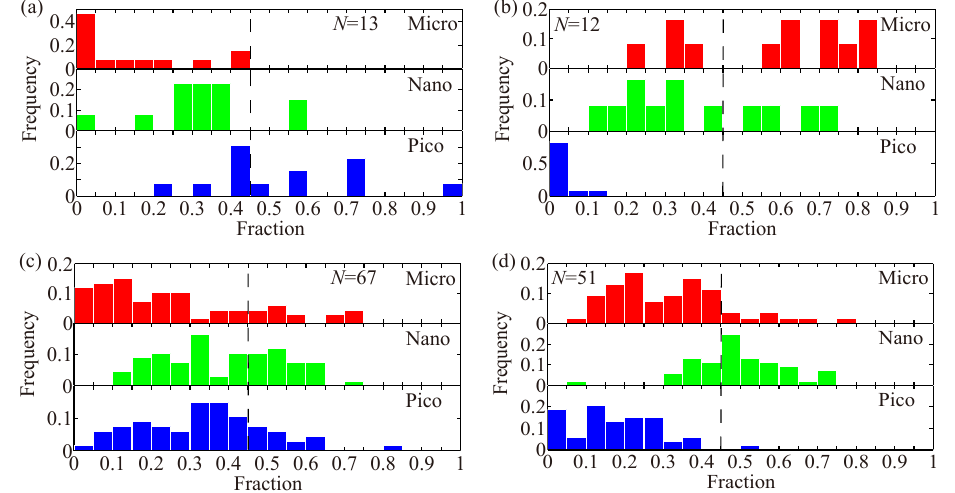
Fig. 5. Histograms showing the frequency distributions of Tchl a size-fractions of micro-, nano- and pico-phytoplankton in the Tsushima Strait surface (a) , Tsushima Strait SCM (b) , East China Sea surface (c) , and East China Sea SCM (d) . Grey vertical lines are the boundaries of the dominant class with a fraction >